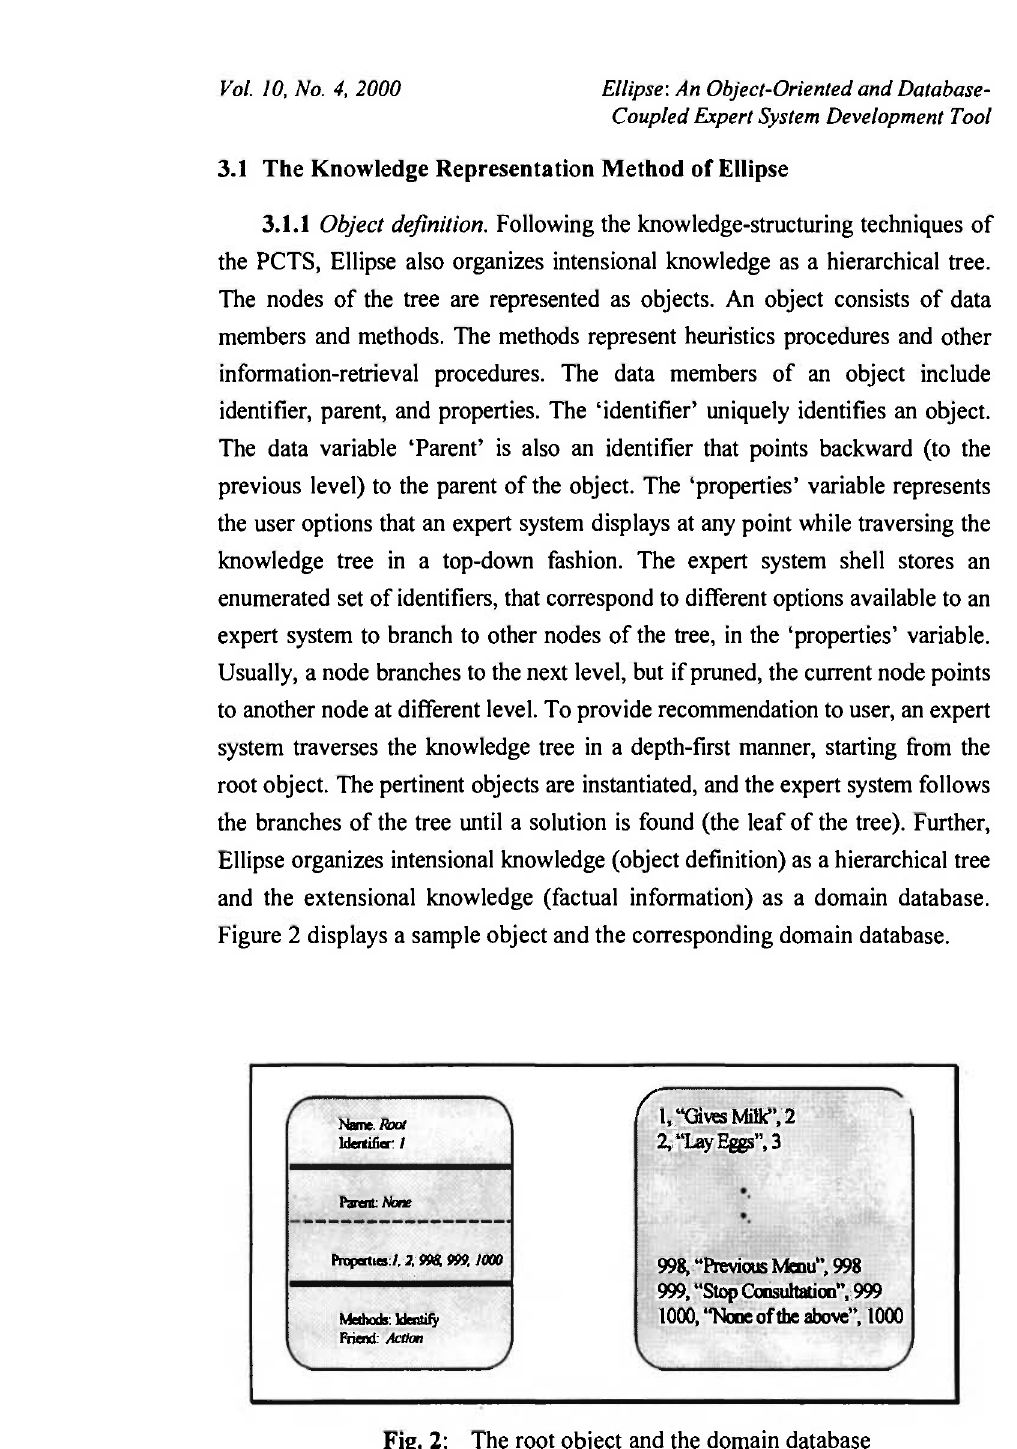
Fig. 2: The root object and the domain